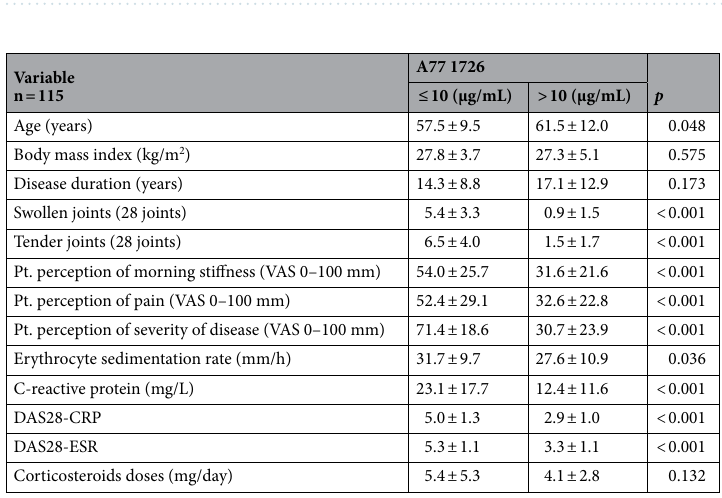
Table 3. Comparison of characteristics between RA patients with serum A17 7726 concentrations ≤ 10 µg/ mL versus RA patients with serum A17 7726 concentrations > 10 µg/mL. Comparisons of proportions between groups were computed using chi-square tests or Fisher’s exact test. Corticosteroid doses in equivalence of prednisone, ESR erythrocyte sedimentation rate, CRP C-reactive protein, VAS visual analogue scale, Pt patient, DAS28 disease activity